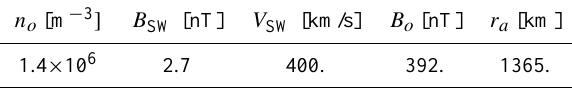
Table 3. Plasma parameters and the object radius.